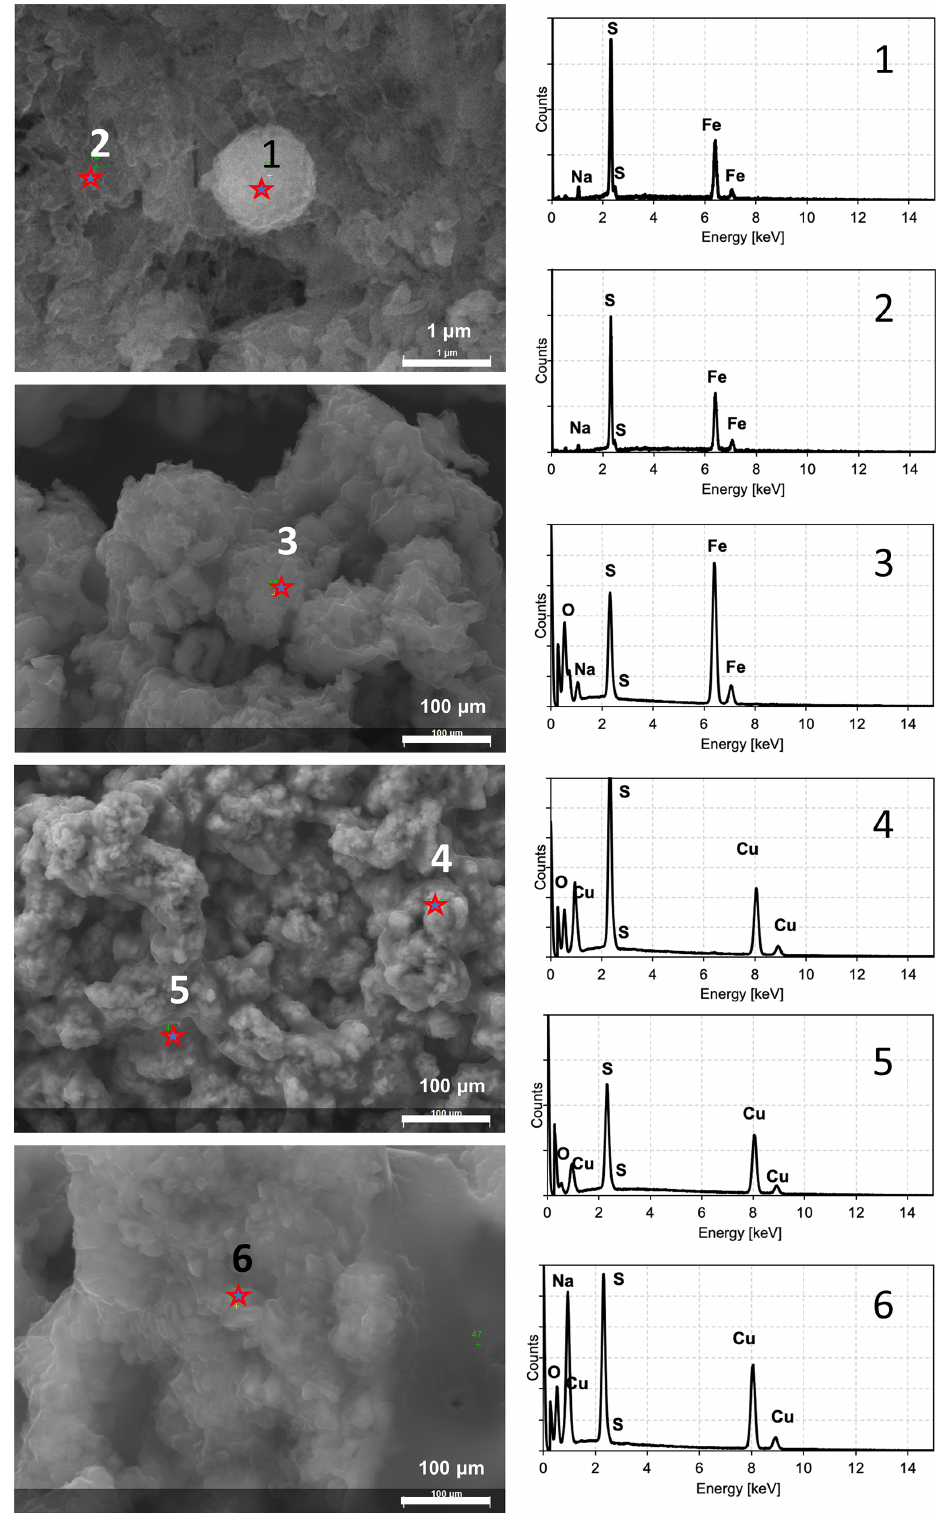
Figure 5. SEM images and EDS spectra characterizing the observed minerals after experiments. Spectra 1 and 2 indicate FeS precipitates. Spectrum 3 probably indicates sulfates due to the strong oxygen signal in relation to sulfur. Spectra 4 and 5 indicate CuS minerals. Spectrum 6 indicates possible impurities due to the presence of sodium (strong signal in relation to